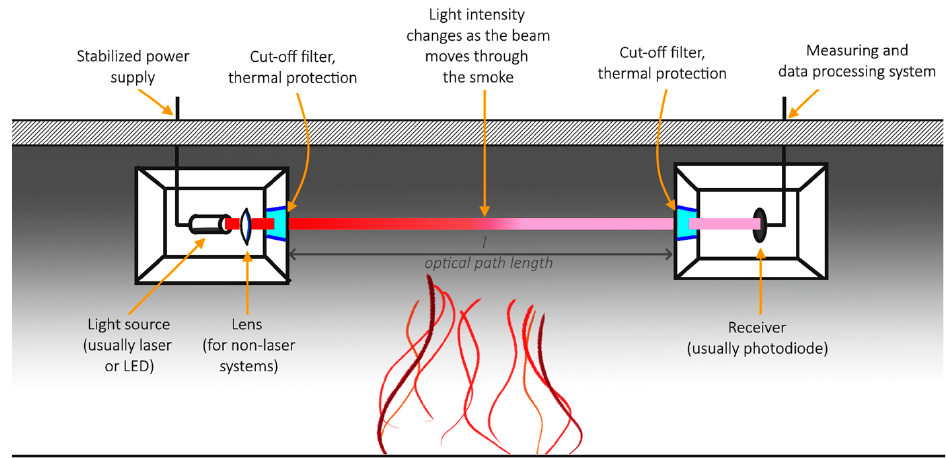
Figure 1. The idea of optical densitometers for smoke obscuration in fire experiments.